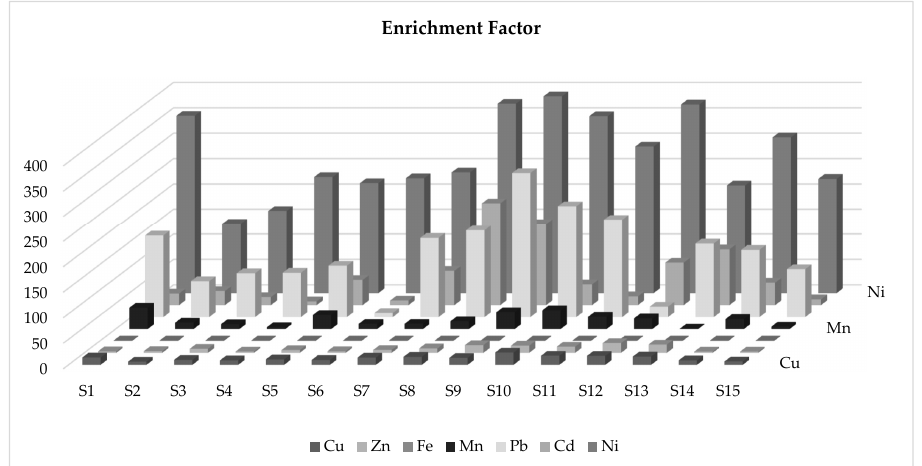
Figure 4. Metal enrichment of all heavy metals in River Surma.